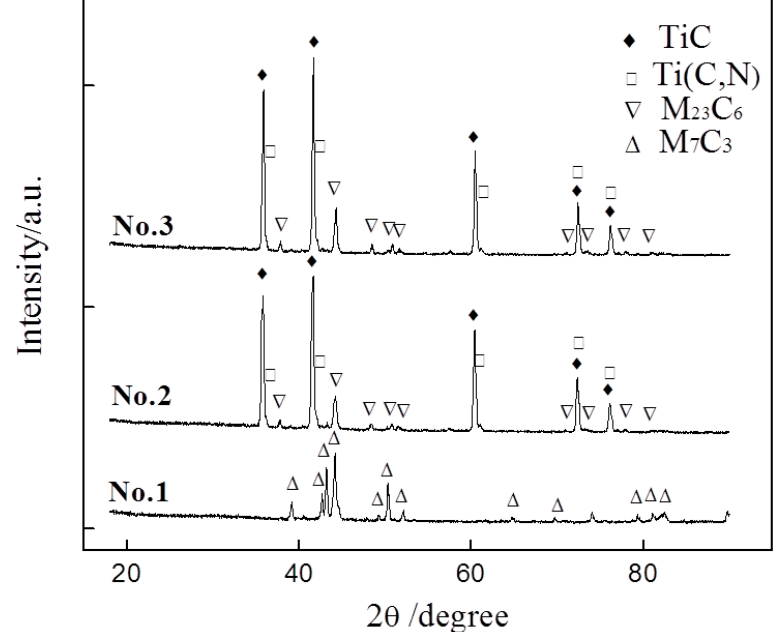
Figure 6. XRD results for three samples with different titanium content: ( a ) sample No. 3; ( b ) sample No. 2; ( c ) sample No. 1.